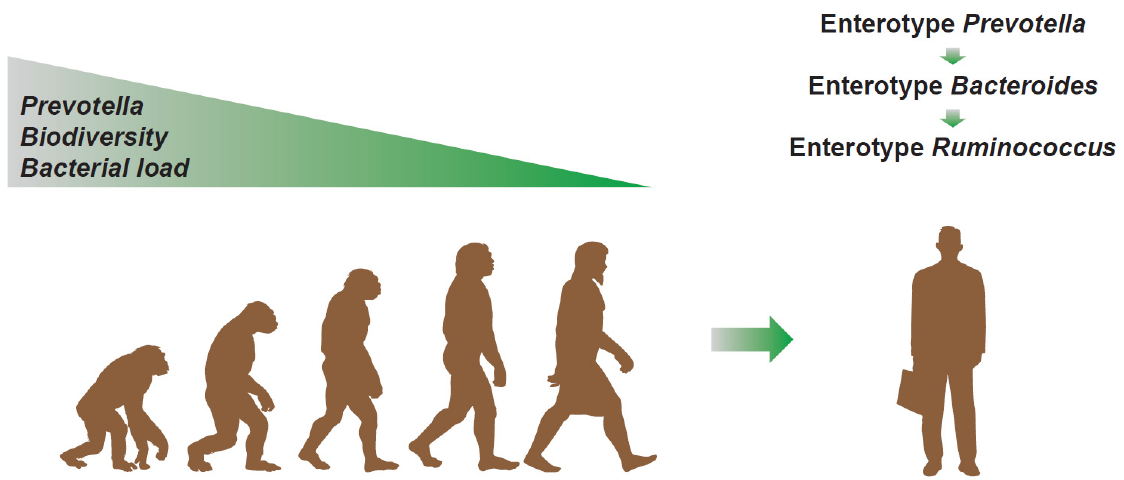
Figure 5. Evolutionary hypothesis of the human gut microbiota based on the parameters of dominance, biodiversity, and bacterial load and based on the structure of the enterotype.